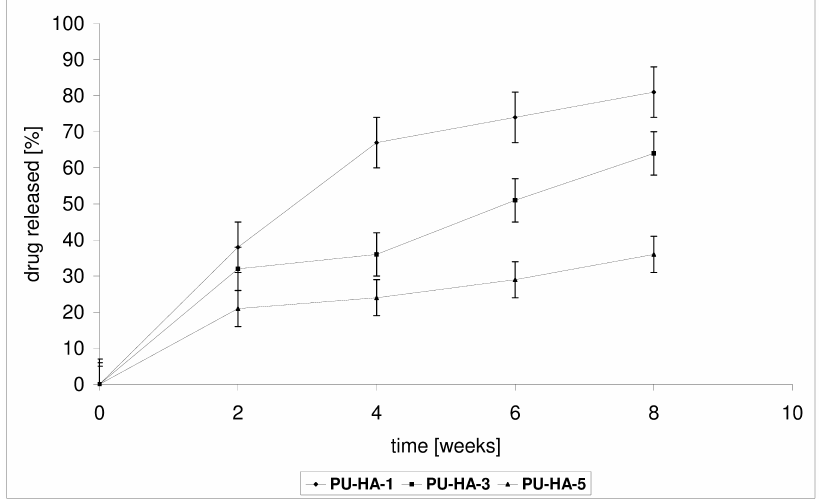
Figure 7. Release of CLO from the PU-HA-1, PU-HA-3 and PU-HA-5